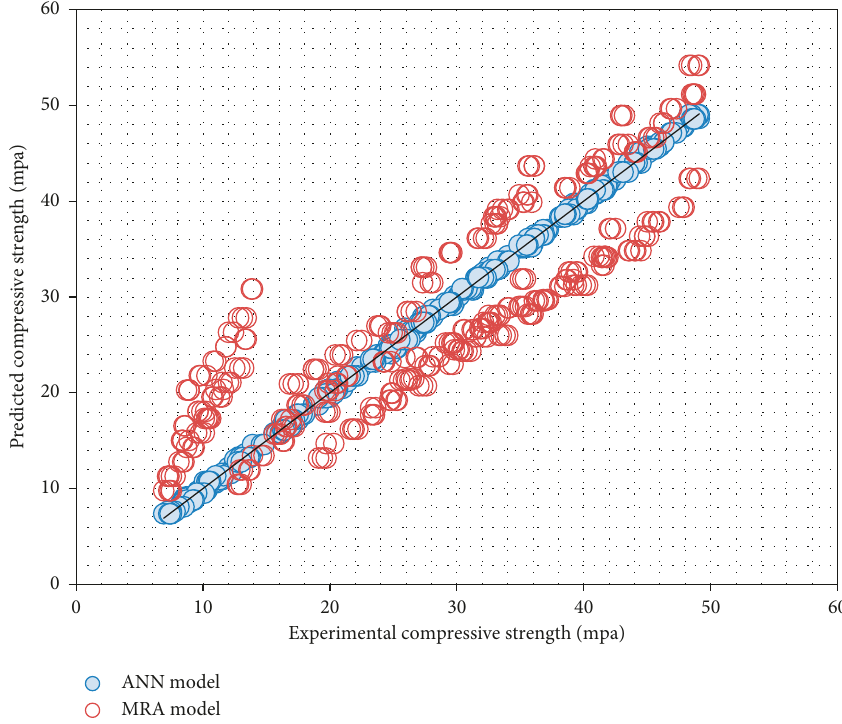
Figure 15: Predicted compressive strength versus experimental compressive strength for models ANN1 and MLR1.